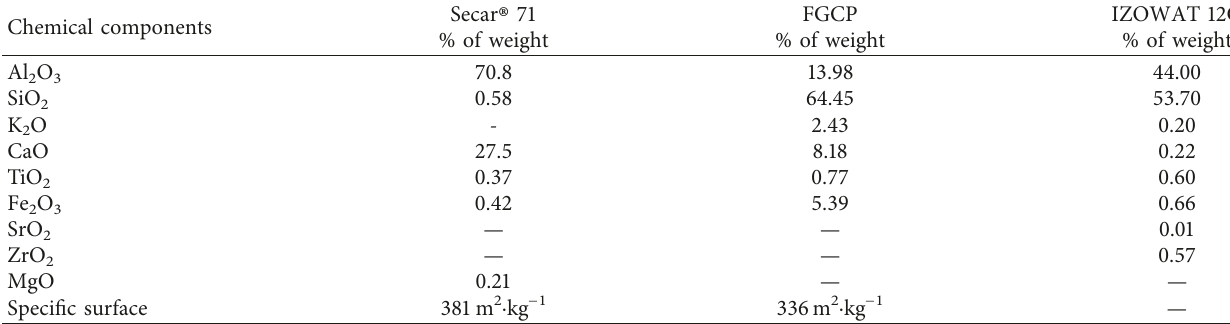
Table 1: Chemical composition of studied materials.